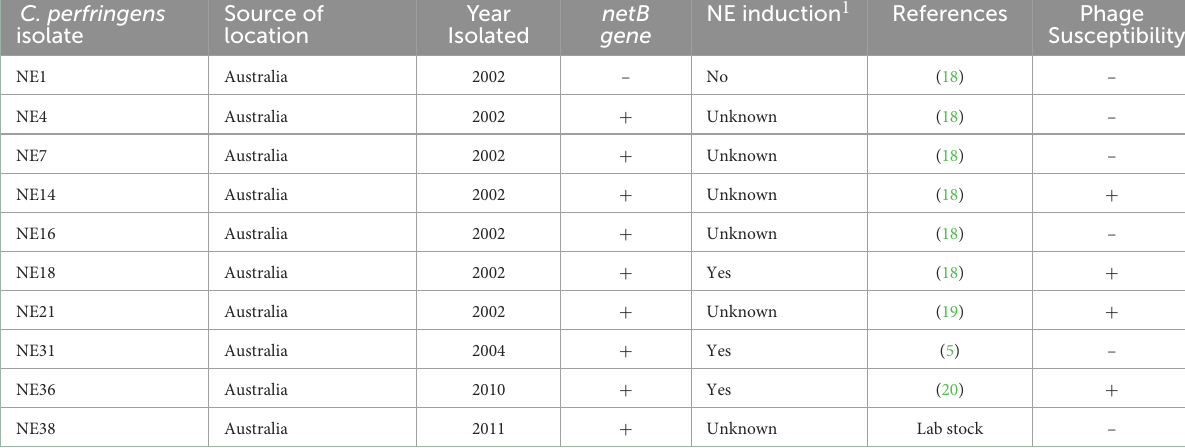
TABLE 1 Characteristics of C. perfringens strains and susceptibility to the